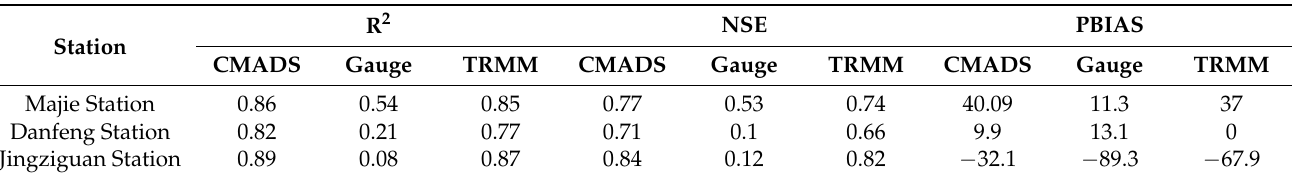
Table 7. The post-calibration performance error amounts of the SWAT model simulated with CMADS, TRMM, and Gauge data on a monthly scale.